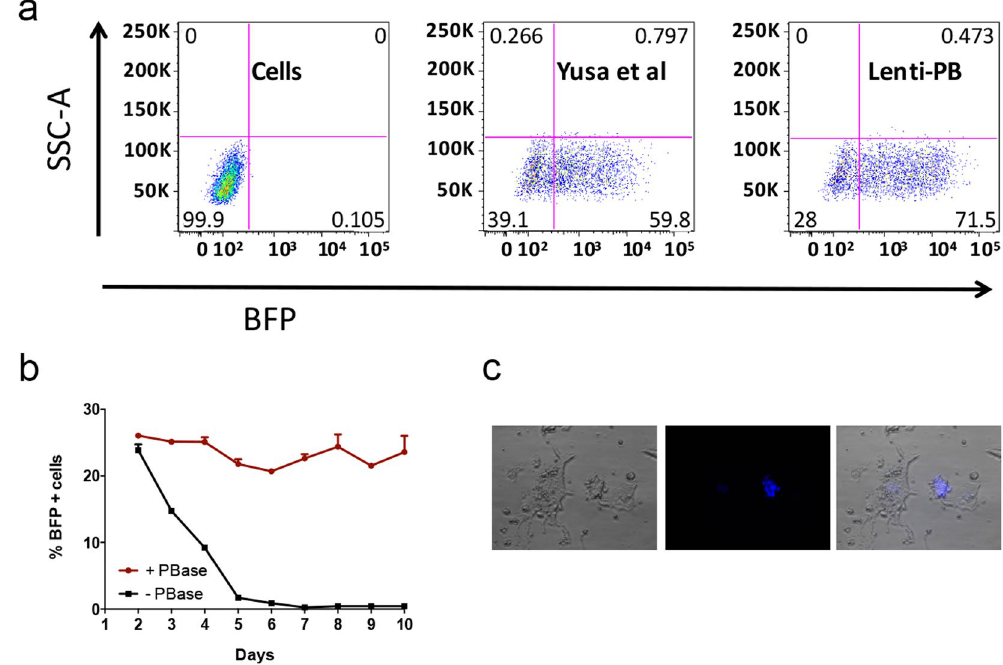
Figure 2. Lenti-PB stable expression by lentivirus or PB transposition. ( a ) BFP flow cytometry analysis of virus packaging and production of Lenti-PB construct compared to the original lentiviral construct in mouse ES cells. No puromycin selection was added to these cells. ( b ) Graph indicating percent of BFP positive cells over ten-day time points of Lenti-PB plasmid co-transfected with PB transposase expressing plasmid (red) for stable integration or with p-bluescript plasmid (black) for transient expression. ( c ) Example of BFP positive mouse embryonic stem cells transfected with